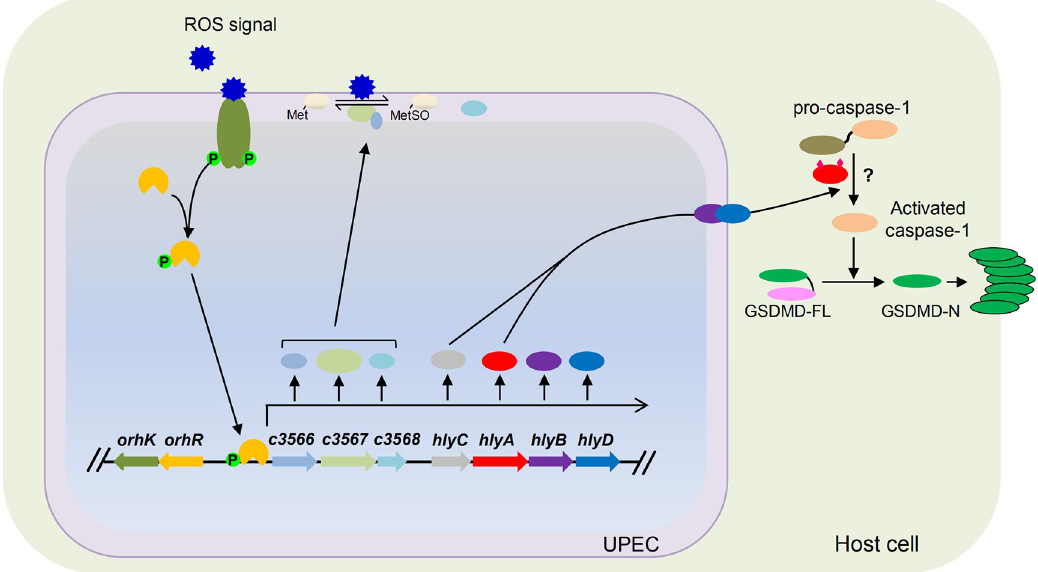
Fig 7. A schematic model of virulence regulation by C3564/C3565 (OrhK/OrhR). We propose that once inside host macrophages, UPEC is able to sense the presence of ROS through the histidine kinase (HK) C3564, which, in turn, transphosphorylates the response regulator (RR) C3565; phosphorylated C3565 is an active form and therefore binds to the promoter region of c3566 and upregulates c3566 - c3568 - hlyCABD expression. Upon acylation by HlyC, hemolysin encoded by